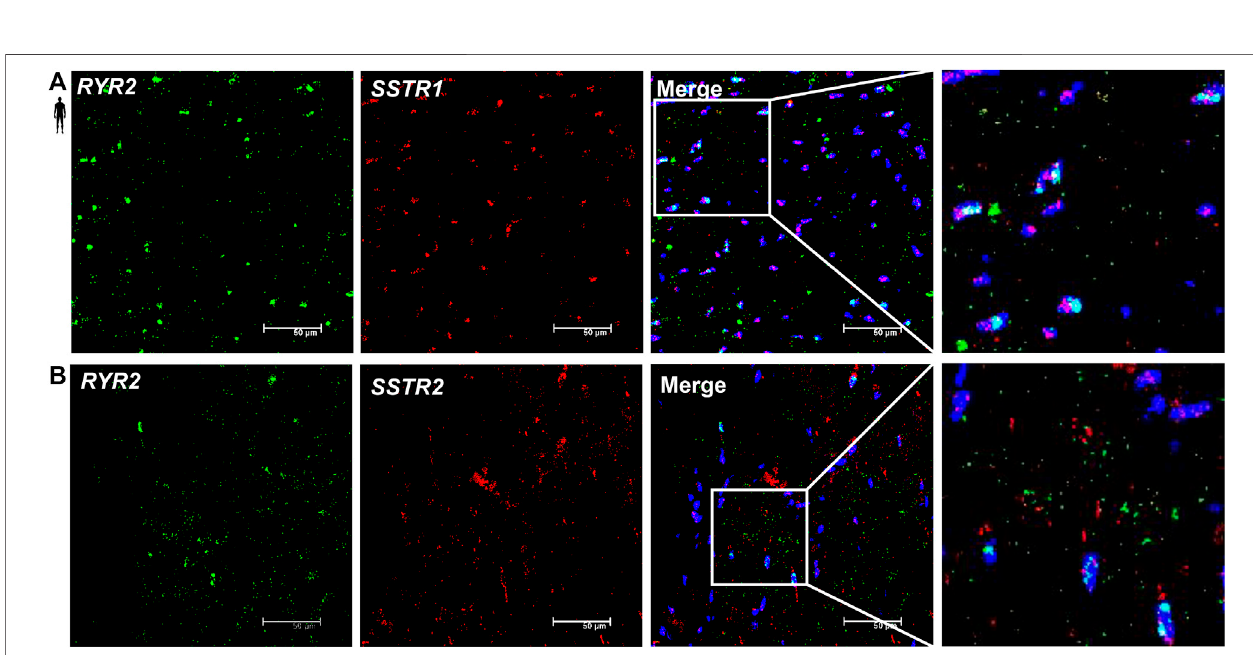
FIGURE 8 | Representative confocal microscopy images of RNA Scope ® - SSTR1 (A) and SSTR2 (B) mRNA expression in histological samples of human control left ventricle. Nuclei were stained with DAPI (blue). Fluorescein-labeled tyramide (green) was used to visualize mRNA of RYR2 (myocardial marker) and Cy3-labeled tyramide (red) was used to visualize mRNA of SSTR1 or SSTR2 , respectively. Scale bar represents 50 µm.